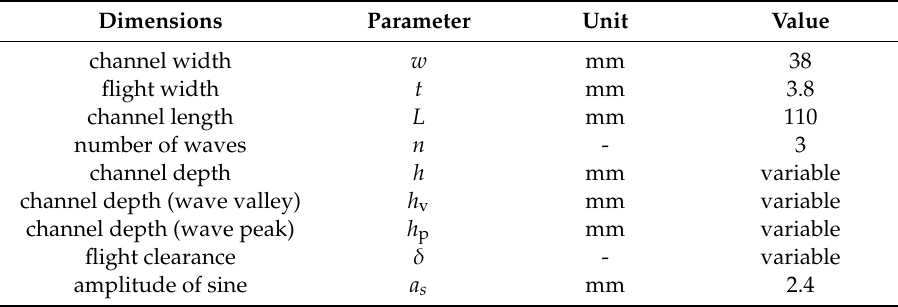
Figure 5. The left-hand side shows the main components of the extrusion die: ( 1 ) bottom plates, ( 2 ) flow channels, ( 3 ) barrier flight, and ( 4 ) top plate. The right-hand side illustrates a top view of the die, indicating the positions of the pressure transducers and the melt temperature sensor. Table 4. Geometrical parameters of the flow